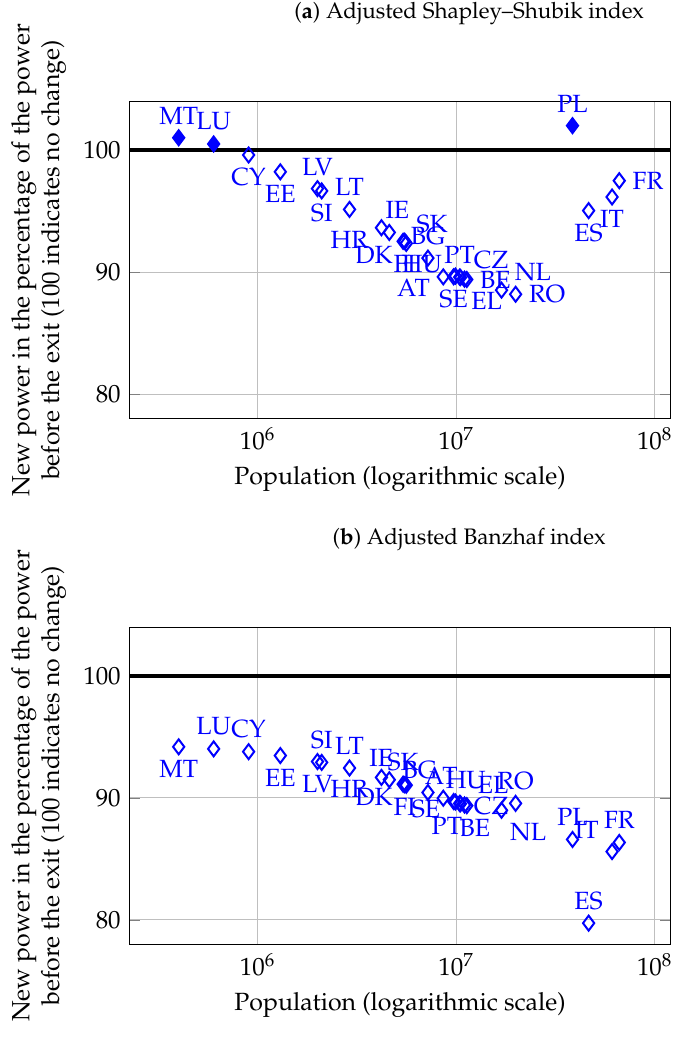
Figure 3. Effect of the German exit with populations for 2015.